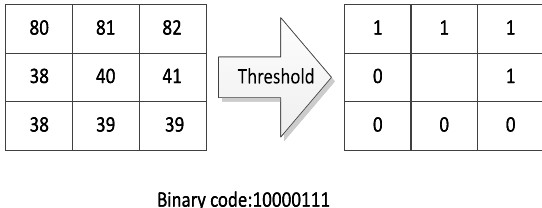
Figure 1. The original LBP